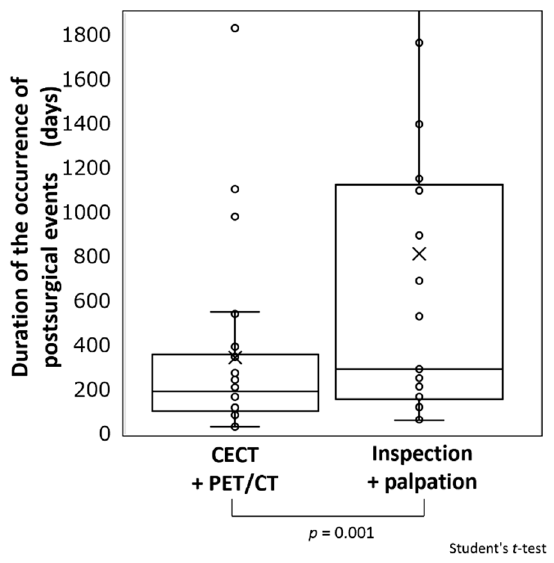
Figure 4. Comparisons of periods until occurrence of postsurgical events. The mean times for occurrence of all postsurgical events and local recurrence, cervical lymph node metastasis, and distant metastasis were 206.5, 411.9, 169.4, and 304 days, respectively. Half of all of the events occurred within 200 days (Q 2/4 155.5, 200.5, 137.5, 189), and 75% occurred within 400 days (Q 3/4 287, 2352.5, 277, 394). The mean time for the occurrence of second primary cancer was 1589.7 days (Q 2/4 1153 days, Q 3/4 2196 days), indicating significantly later onset compared with other events ( p < 0.001). In the figure, “ × “ indicates the mean value and “ “ indicates the event occurrence per patient. (cid:35)